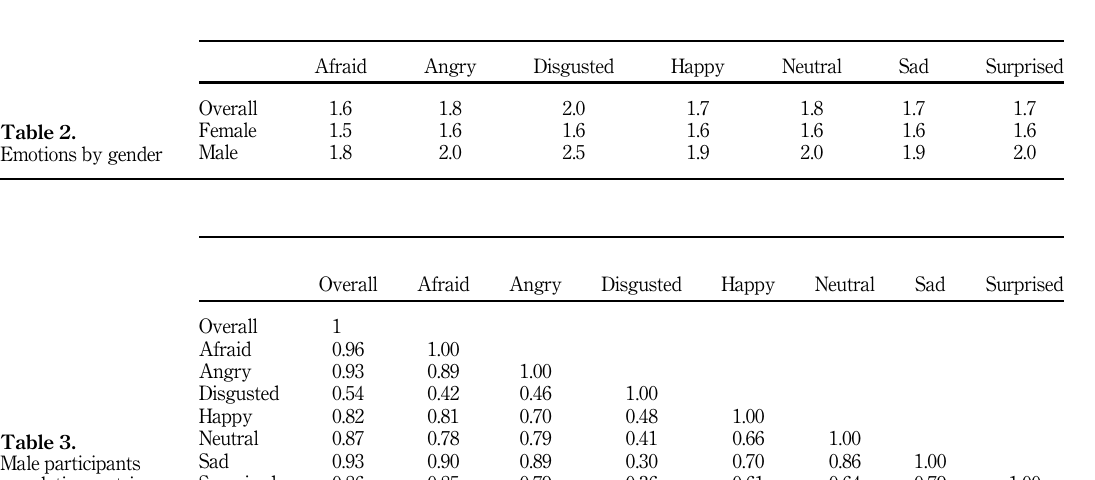
Plate 3. Heat map obtained from overall results of all participants